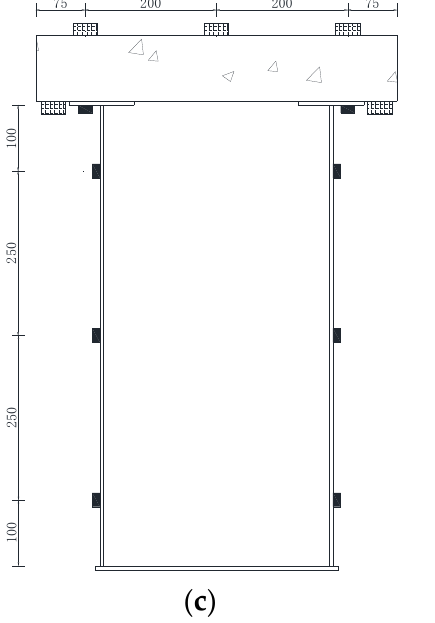
Figure 5. Layout of Strain Gauge on specimens SRB and SPB (unit: mm). ( a ) Top view of strain gauge on top surface of concrete slab, ( b ) Elevation view of strain gauge on concrete slab and steel box girder web, ( c ) layout of strain gauge at intermediate support section. Three dial gauges for displacement meters were employed in three key sections to measure the relative interface slip. The specific layout and fixing method are shown in Figures 6 and 7.